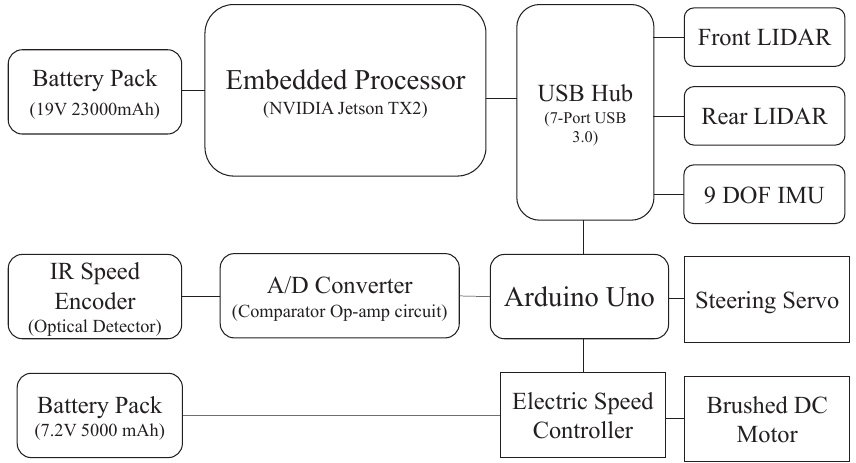
Figure 2. Component interconnection diagram of PSU BOT .